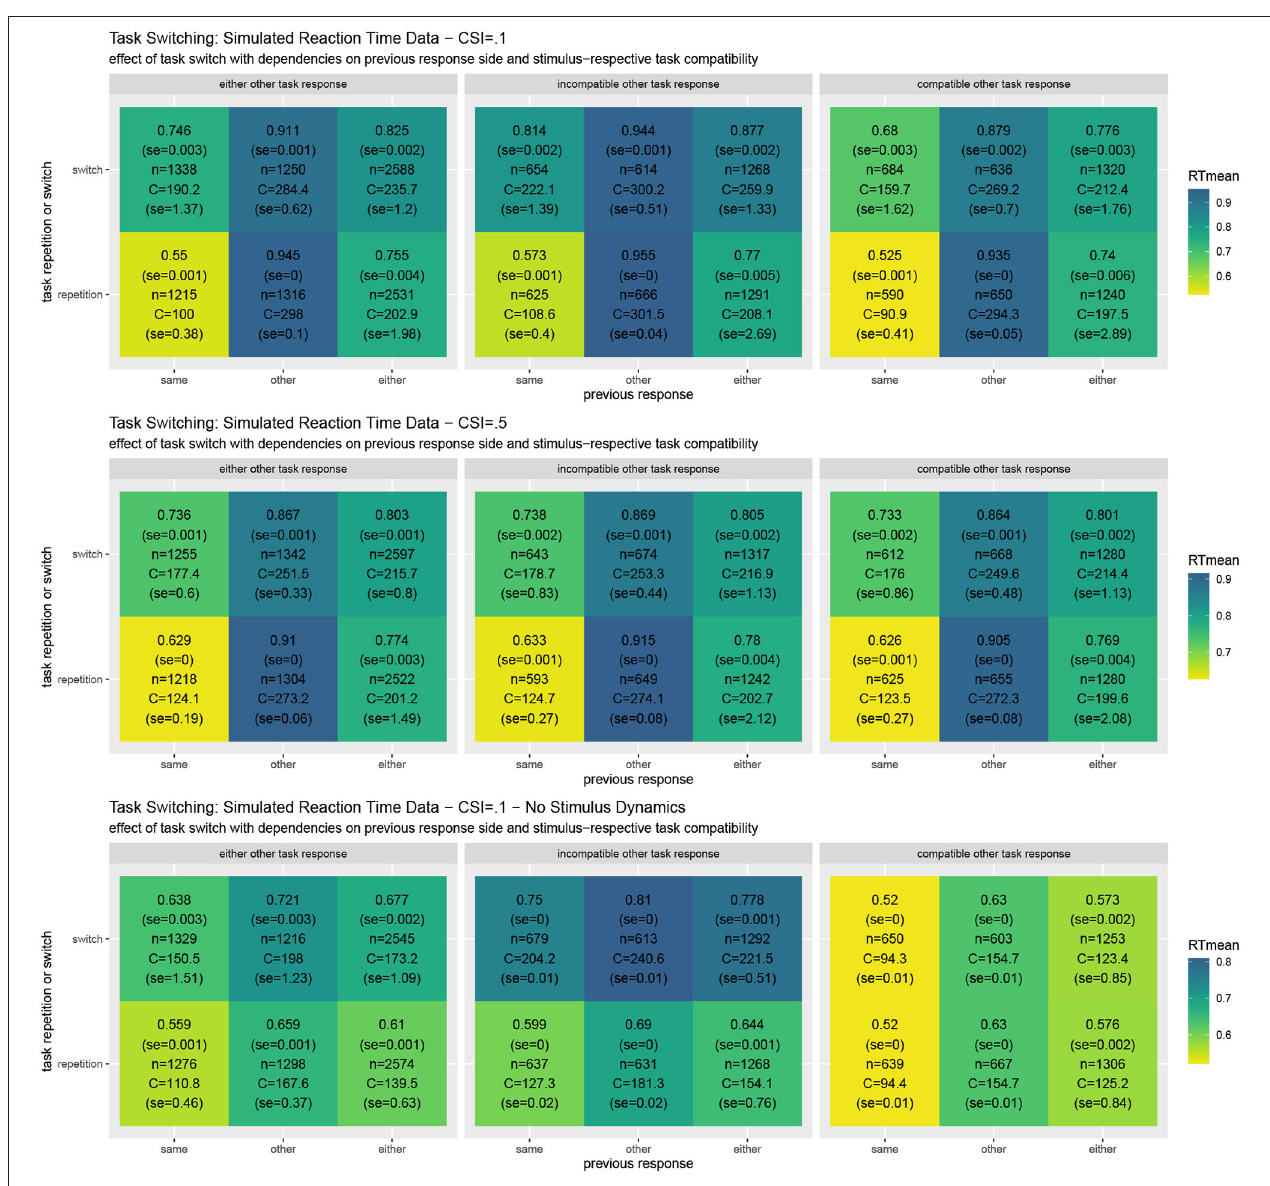
FIGURE 5 | Results of task switching simulations averaged over twenty experiments for the full REPI model with all dynamics simulating a cue-stimulus interval of 100 ms (top row) . When this interval is enhanced to 500 ms (middle row) , the task switching effect decreases, as is well-known from results in the task-switching literature. When the stimulus density is set directly to the actual stimulus value, the predicted response distributions undergo fewer dynamical interactions (bottom row) . The basic REPI simulation without further parameter optimization yields reaction times that depend on whether a task switch occurred (cf. “either” column in the left block). Additionally, a strong previous response side benefit is generated, yielding faster responses for the same response side. Moreover, the compatibility of the response to the other task in a trial plays an important role (center vs. right block of reaction times). When the stimulus is assumed to be processed instantly (bottom row) , the expected reversal of the task-switching effect in the case of the other previous response side disappears. Besides the mean reaction times, the numbers report standard error, the number of condition-respective trials, and mean cognitive effort costs C (task) integrated over the time from the stimulus onset until the